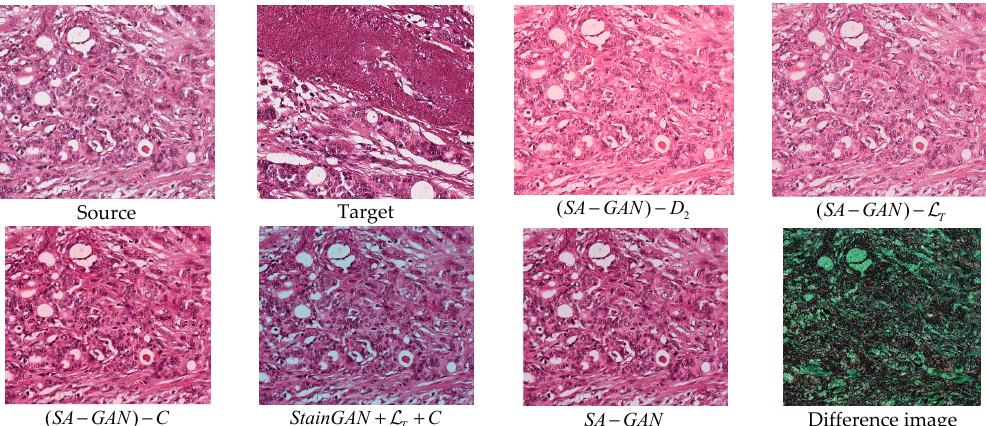
Figure 6. Visual results of different configurations of SA-GAN. “Source” corresponds to randomly selected original training image. “Target” corresponds to original test images selected from ICPR 2014 datasets. The image (given in 2nd row and 2nd column), represents the result obtained with StainGan [28] model when trained with content loss and color attribute metric information. The last image (given in 2nd row and 4th column) represents the absolute difference between the normalized image (obtained with SA GAN − ) and target image.